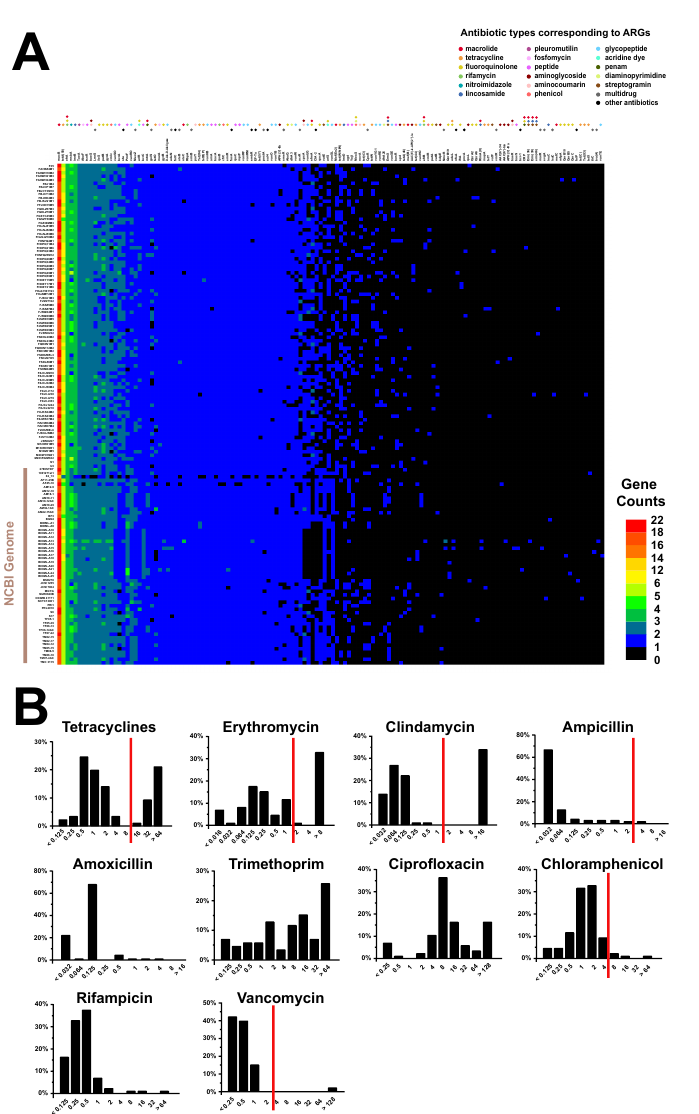
Figure 7. The distribution and the number of potential ARGs in 140 B. bifidum genomes. Gene copy number was indicated by color ranging from dark (absent) to red ( A ). The proportions of strains with different MIC values ( B ). The red lines represent microbiological breakpoints recommended by the